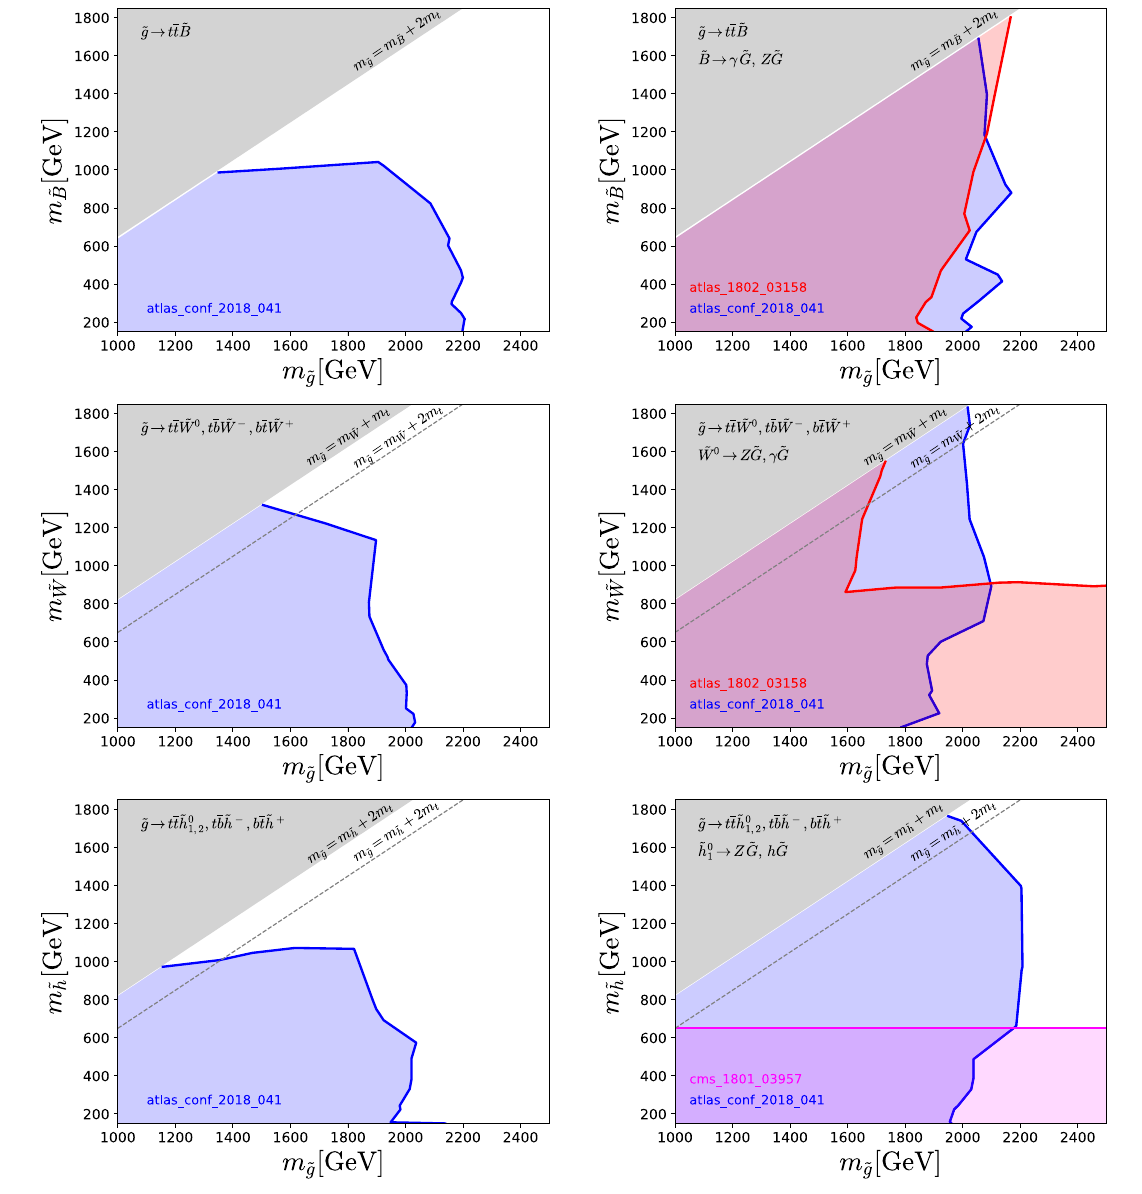
Figure 4 . The exclusion plots in the gluino model, section 4.2. The left column with electroweakino as the LSP and the right column with gravitino LSP. From top to bottom: bino, wino and higgsino case. Only the most constraining analyses are